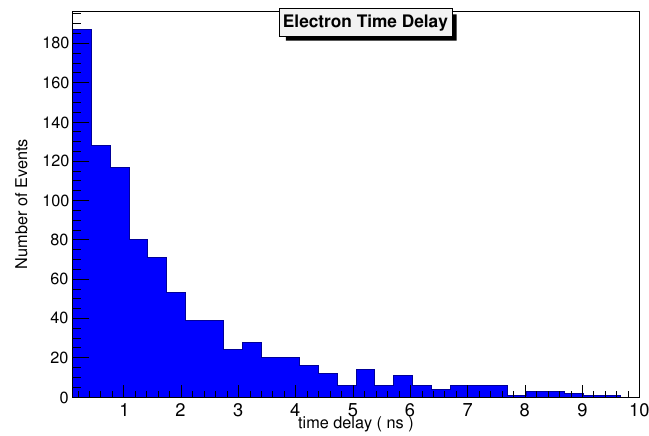
Figure 4 . Distribution of the time delay, (cid:1) t = t the decay of a 50 GeV right-handed neutrino with a mean decay length of c(cid:28) = 1 : 0